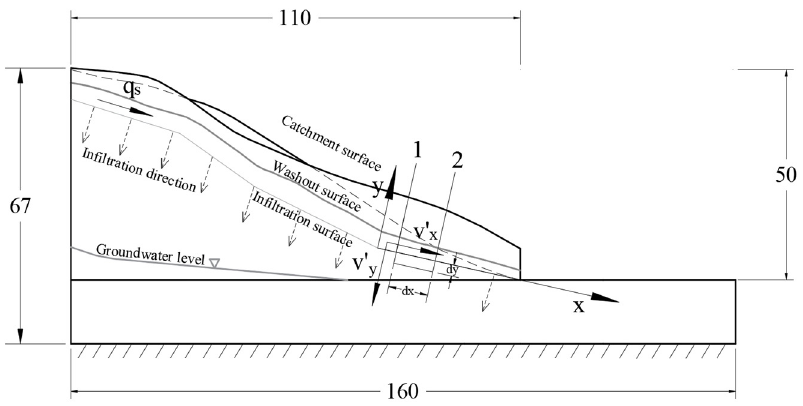
Figure 1. Principle of the washout assay.